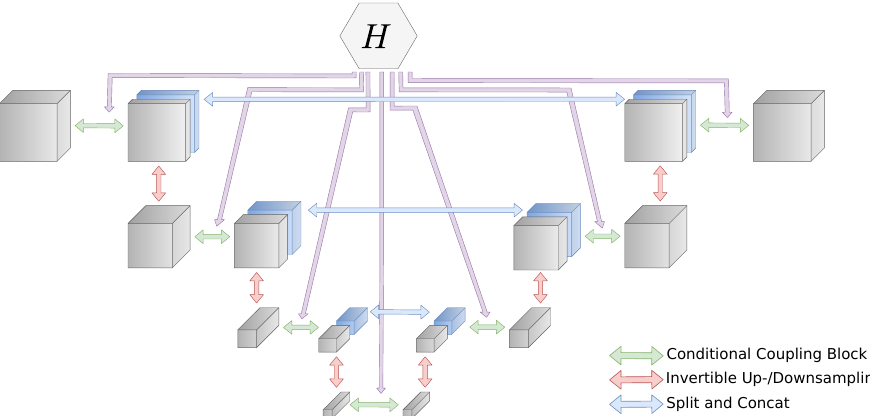
Figure 3. End-to-end invertible UNet with conditioning network H . The conditioning network processes the conditioning input y δ and outputs this to the respective conditional coupling